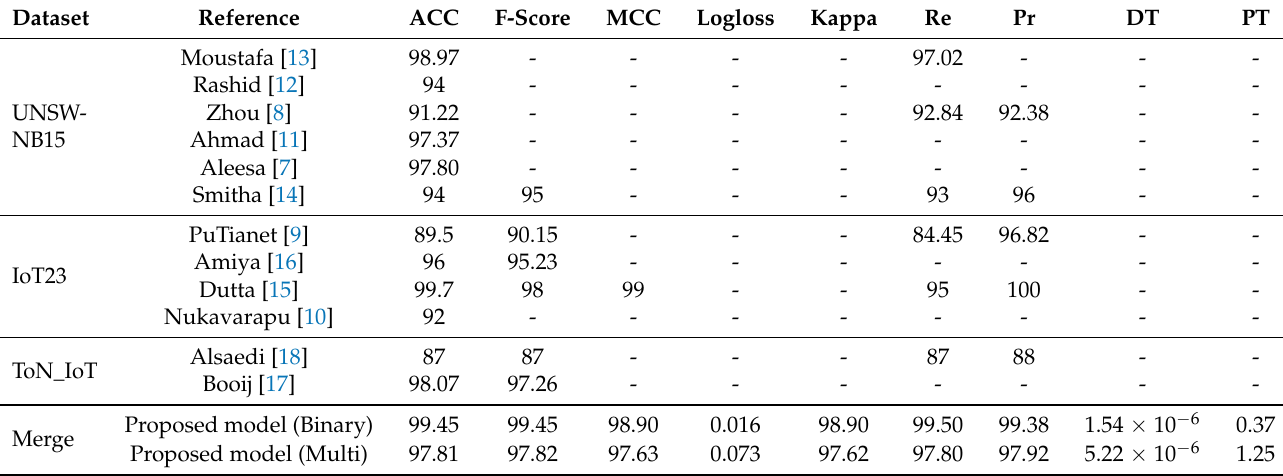
Table 12. State- of-the-Art